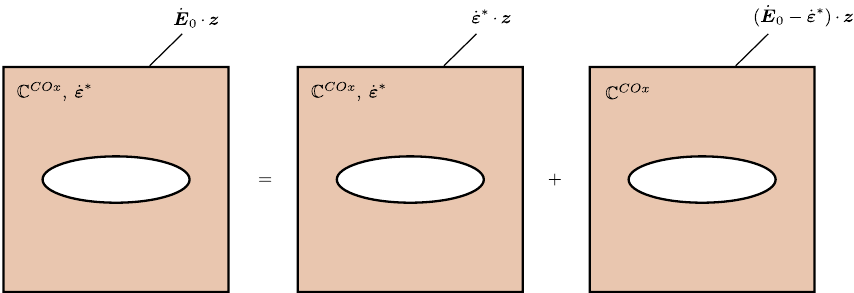
Figure 3. Decomposition of the auxiliary